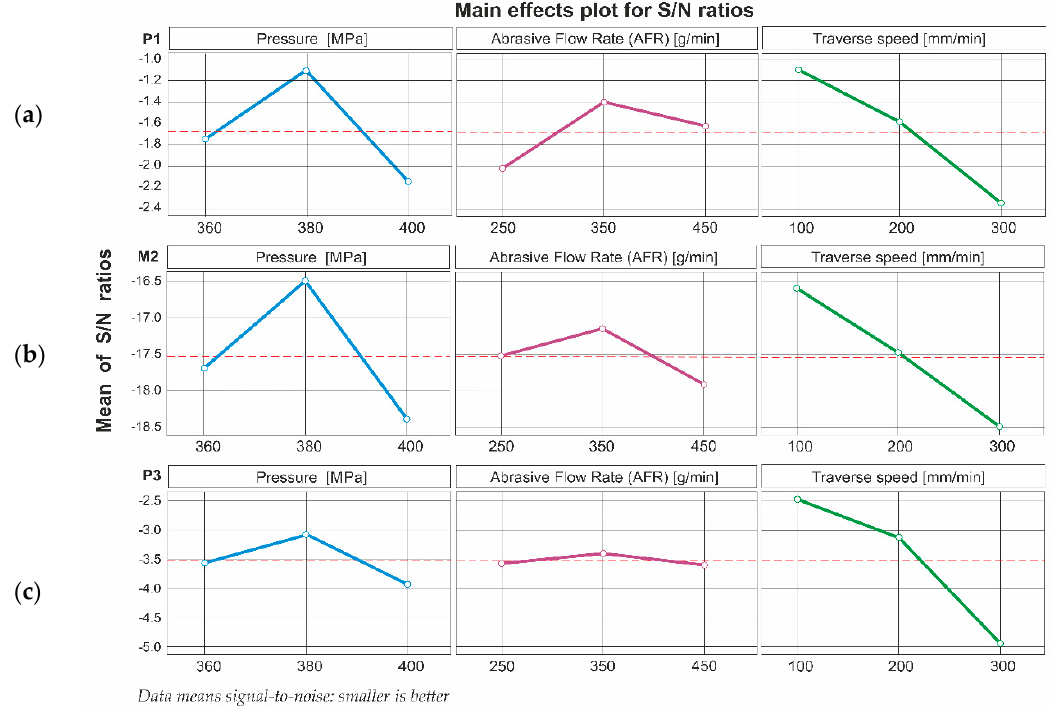
Figure 6. The influence of control parameters on the S/N ratio for surface roughness: ( a ) P1 area, ( b ) M2 area, ( c ) P3 area.